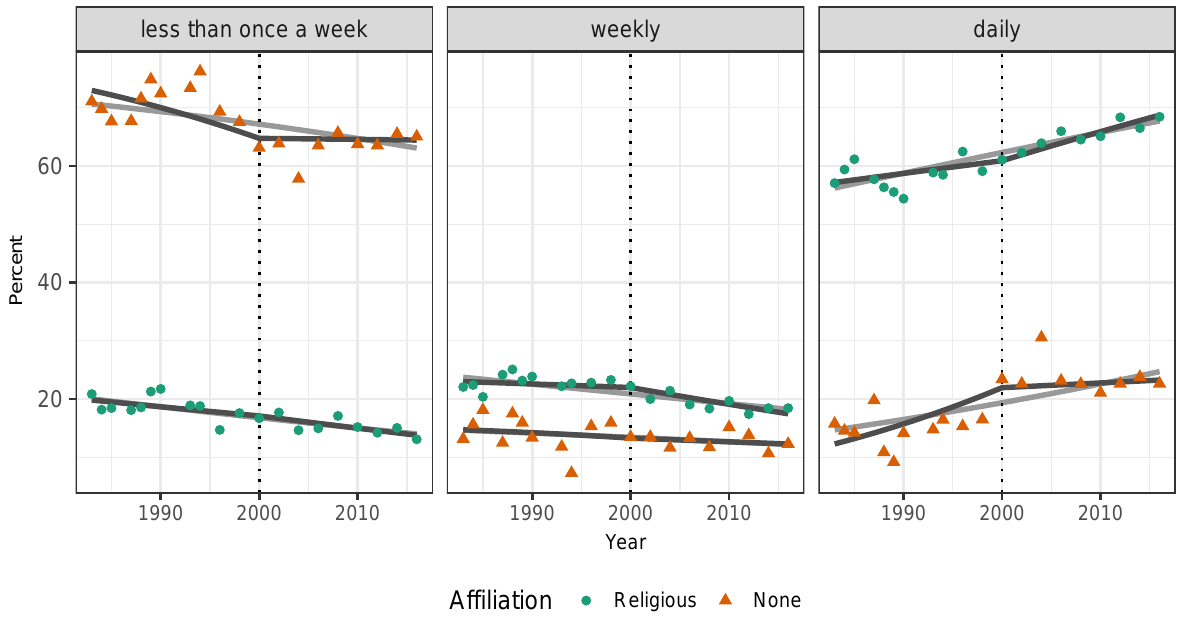
Figure 4: Percentage of General Social Survey respondents in each year who prayed with a certain frequency by affiliation status. All percentages are sample weighted. The fit of multinomial logit models assuming a linear trend and with a hinge at 2000 are shown in light and dark grey,